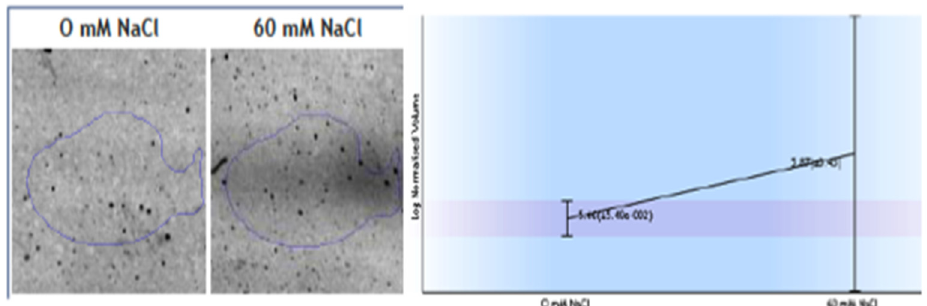
Figure 4. Changes observed in spots identified as root ferredoxin-NADP + reductase (FNR) as a response to 60 mM NaCl. Diaphorase FNR enzymatic activity measured in crude extracts.